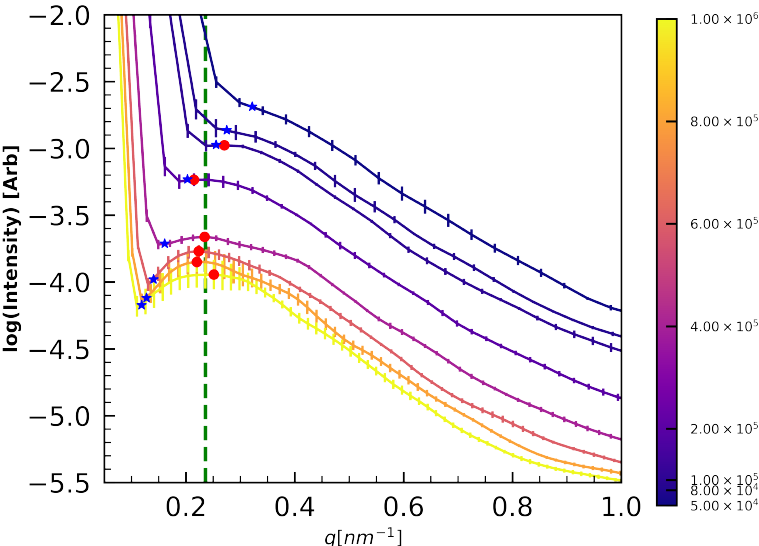
Figure 4. PES-PES structure factor in α = 0.9 simulations shows emergence of a 0.236 ± 0.019 nm − 1 (26 ± 2 nm) feature (dashed green line), too large to resolve in simulations where N ≤ 2 × 10 5 . The color bar indicate system size ( N ). The blue star indicate half of the box